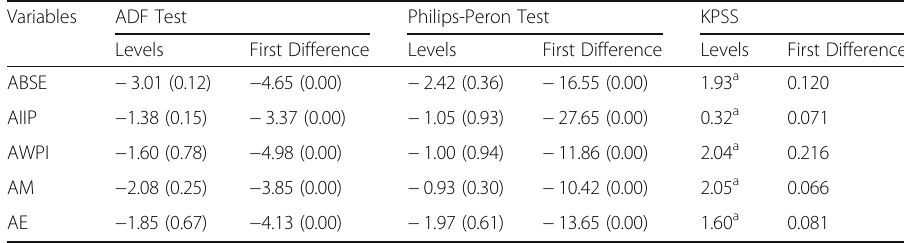
Table 4 Unit Root Test for ACE Transformed Variables Variables ADF Test Philips-Peron Test KPSS Levels First Difference Levels First Difference